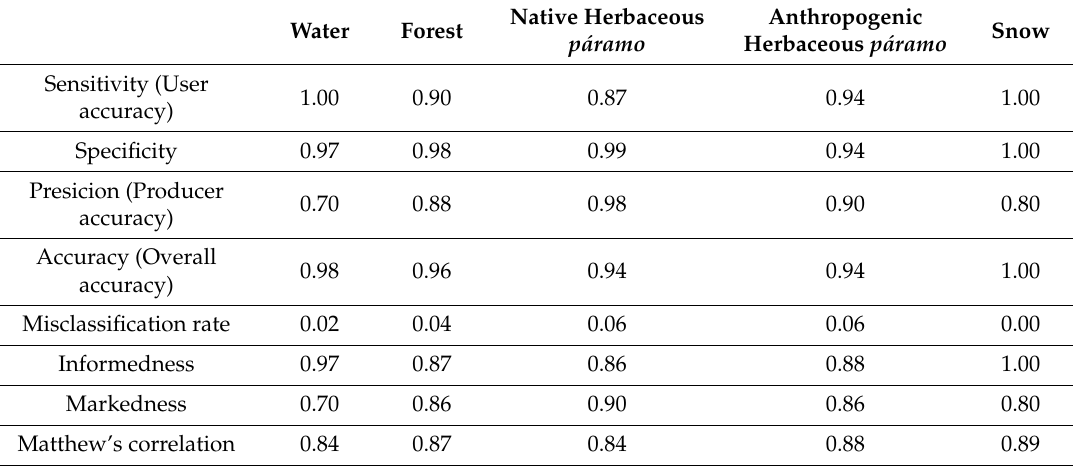
Table 3. Performance of the classification decision tree classifying LULC in Ecuador’s southern